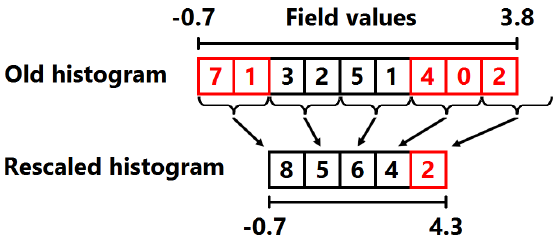
Figure 3. Illustration of a re-scaling for the field distribution histogram for minimal resolution R hist = 4 and bin size changing from B hist = 0.5 to B hist =